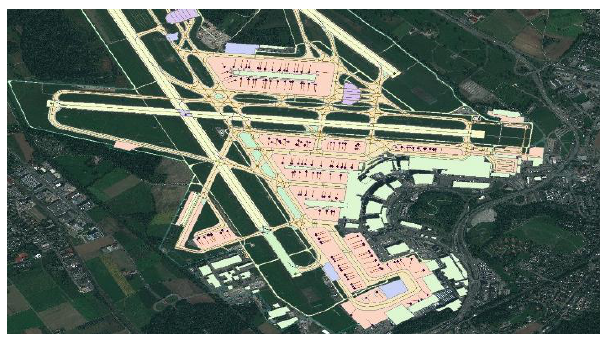
Figure 4: Extracted Features superimposed on